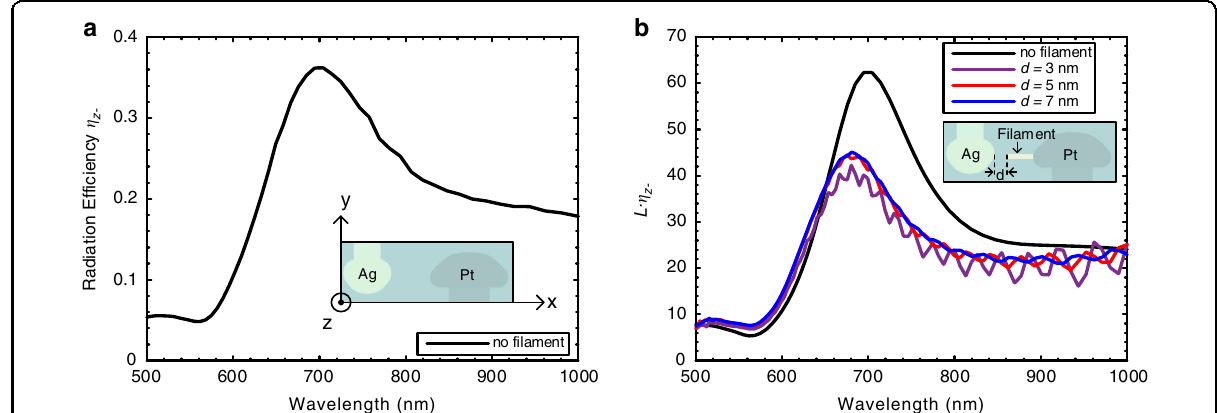
Fig. 4 Investigation of the APS and the in fl uence of the antenna and the fi lament on its emission. a Simulation of the antenna radiation ef fi ciency (effect of fi lament not included). Inset, the Ag and Pt nanoantenna structure considered for the simulation are shown together with a de fi nition of the orientation. The shape of the antenna is extracted from the SEM image shown in Fig. 1. b Simulated quantum ef fi ciency L · η z- as a function of the fi lament-antenna gap d . Inset, the structure of the Ag and Pt nanoantenna used in the simulation. The fi lament is modeled as a cylindrical Ag rod with a radius of 0.5